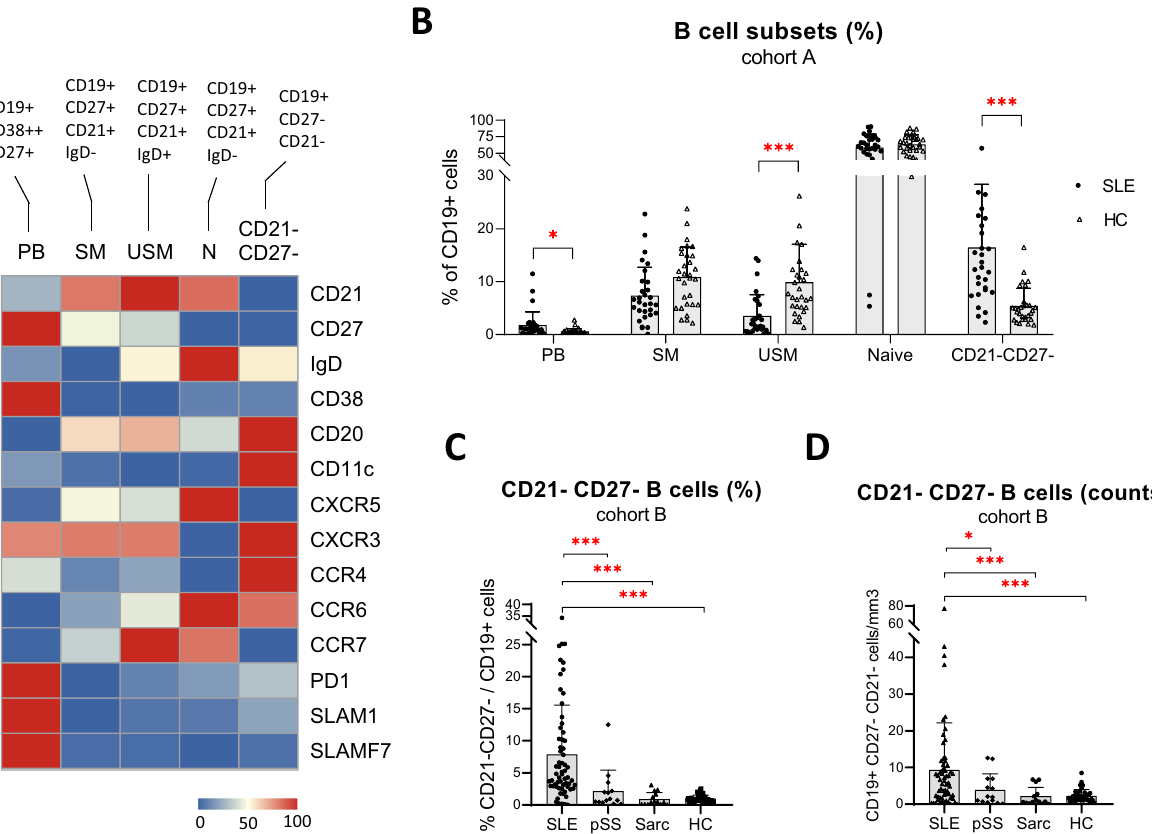
Figure 3. Analysis of B cell subsets using manual gating in systemic lupus erythematosus (SLE) compared to healthy and disease controls. ( A ) Heatmap showing mean levels of expression of surface markers in manually gated B cell subsets: naive (N), switched memory (SM), unswitched memory (USM), CD21 − CD27 − B cell and plasmablast (PB). B cells were analyzed by mass cytometry in 30 HC and 30 SLE (cohort A). Data was normalized by rows. ( B ) Frequency of B cell subsets defined by manual gating using mass cytometry data in 30 SLE compared to 30 HC (cohort A). Bar plots represents mean ± SD. Statistical analysis were performed on log-transformed data (to obtain normal distributions), using a student-test to compare each population in SLE versus controls. ( C , D ) Frequency and absolute counts of CD21 − CD27 − B cell, defined by manual gating of flow cytometry data, in 64 SLE patients compared to 14 primary Sjögren’s syndrome, 14 sarcoidosis and 39 HC (cohort B). Bar plots represents mean ± SD. Statistical analysis were performed on log-transformed